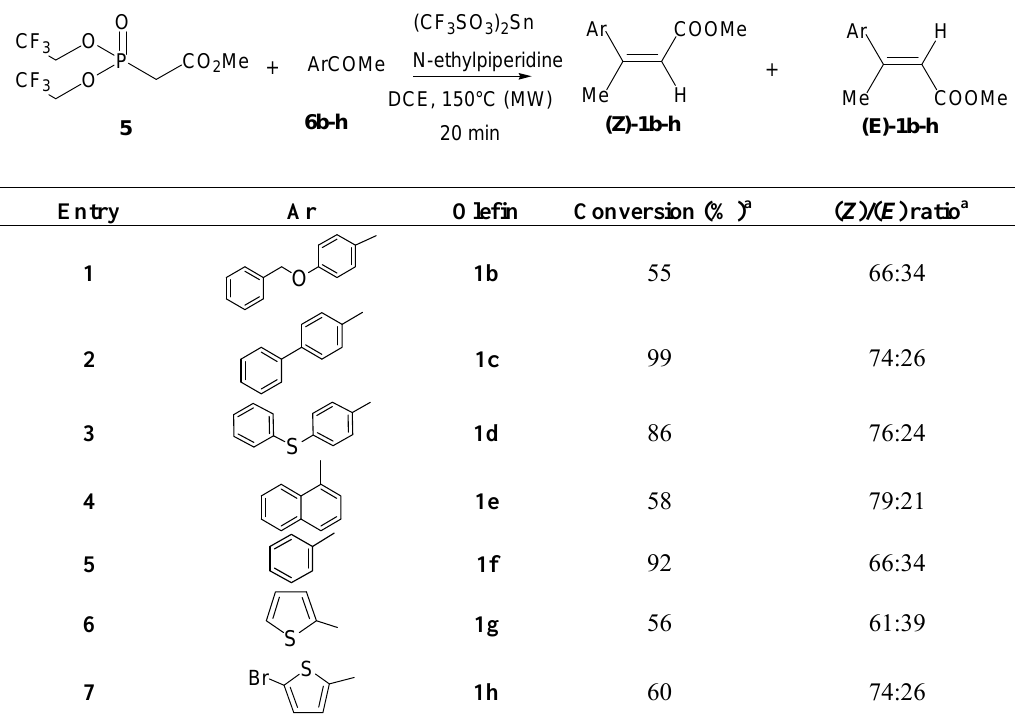
Table 2. HWE olefination of aryl methyl ketones 6b-h